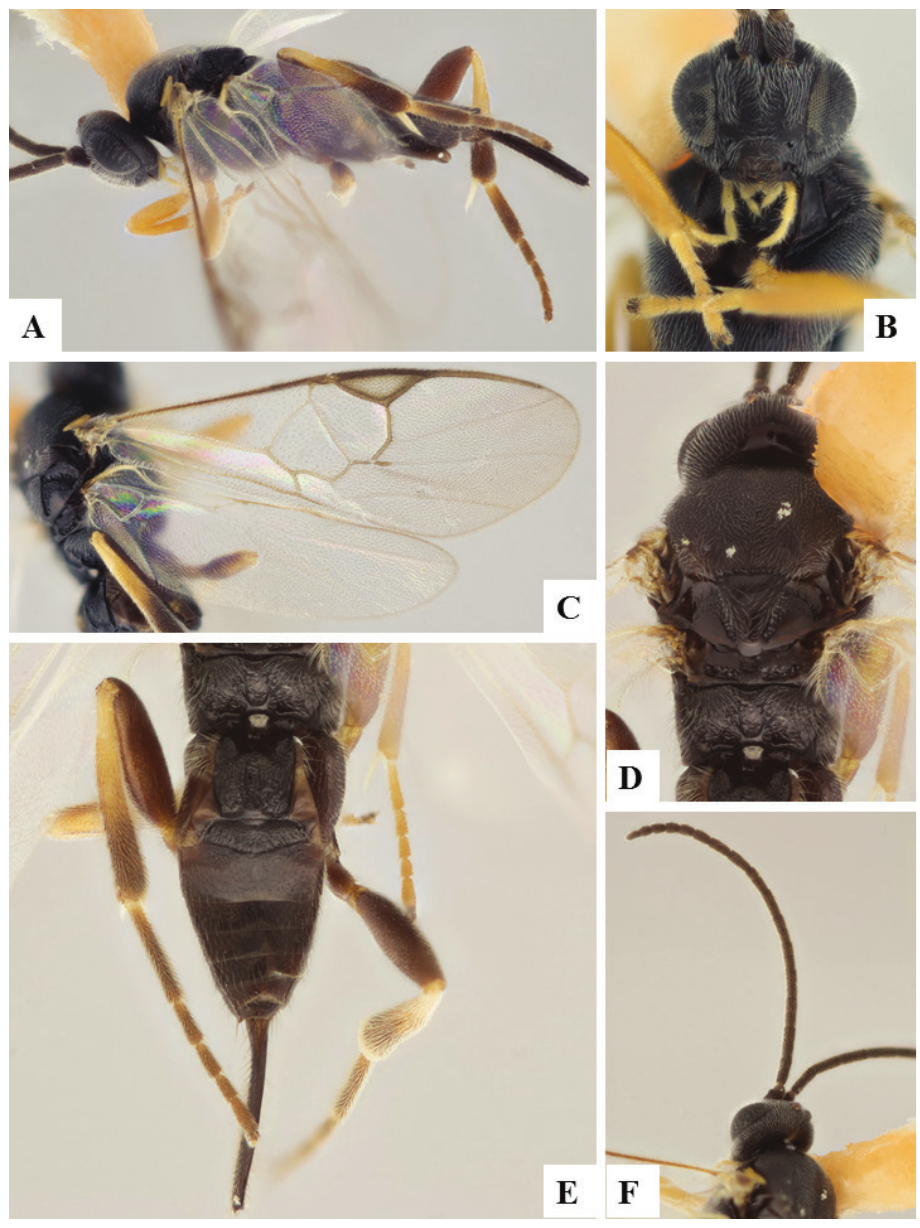
Figure 10. Apanteles petrovae. A Habitus, lateral B Head, frontal C Wings D Cocoon E Head and mesosoma (partially), dorsal F Head and antenna, ventrally G Metasoma,